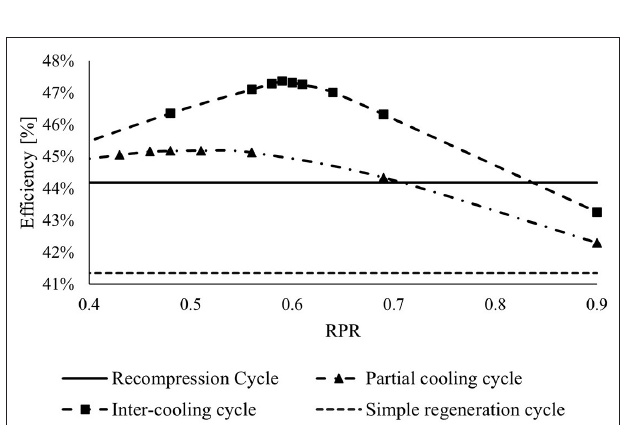
FIGURE 5 | Effect of the RPR and therefore of intermediate pressure on cycle